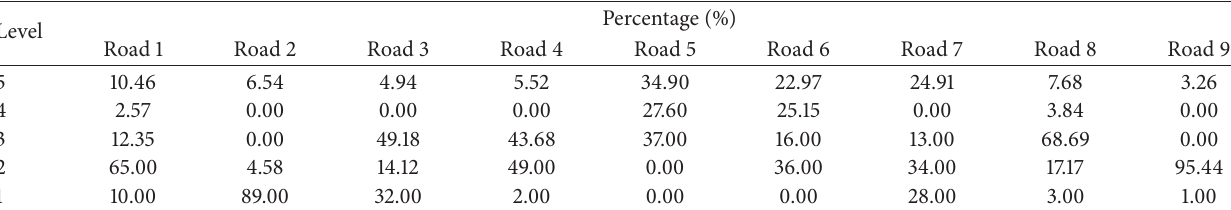
Table 6: Safety risk level summary results.